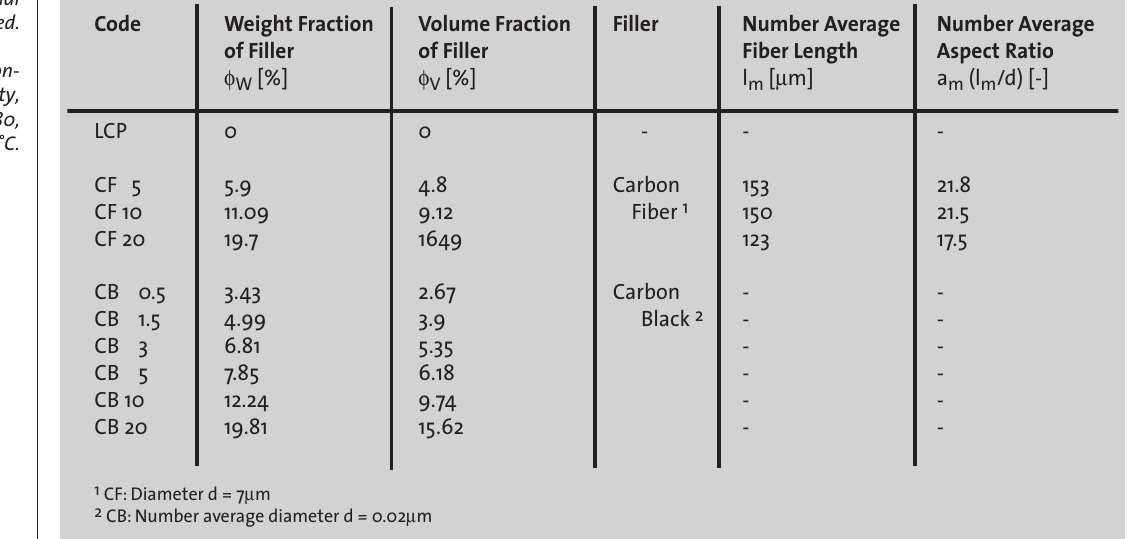
Table 1 (above): Material used. Figure 1 (below): Relation- ship between LCP viscosity, h and shear rate, g · , at 280, 290, 300 and